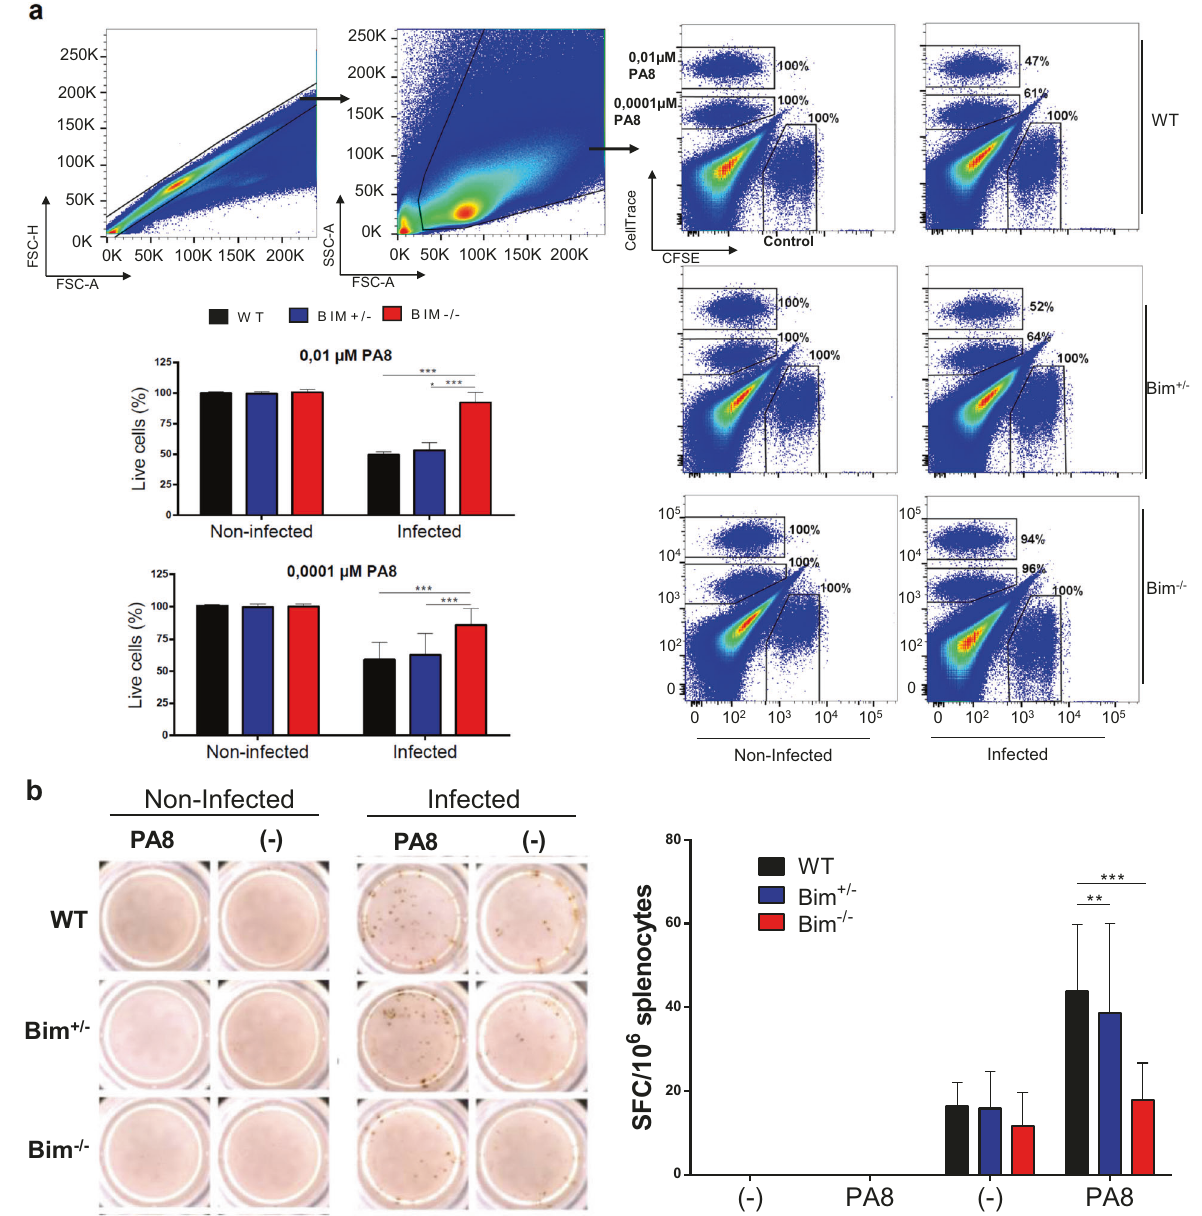
Fig. 4 Bim − / − mice have impaired antigen-speci fi c CD8 + T cells response against T. cruzi in the acute phase of infection. C57BL/6 WT , Bim + / − , and Bim − / − mice were inoculated i.p. with 1 × 10 4 trypomastigotes of the Y strain of T. cruzi . A Eight days after infection, mice were inoculated with 3 × 10 7 splenocytes divided into three populations (1:1:1) stained with 1 μ M of CFSE (control), 1 μ M of CellTrace violet (CTV low - pulsed with 0.0001 μ M of PA8 peptide) and 10 μ M of Cell trace (CTV hi - pulsed with 0.01 μ M of PA8 peptide). Sixteen to twenty hours after cell transfer splenocytes were harvested and speci fi c lysis of target cells was determined by fl ow cytometry. B The frequency of IFN- γ producing cells was measured ex vivo in the presence of PA8 peptide by ELISPOT assay. SFC (Spot forming cells). The results are expressed as the media and standard deviation of fi ve animals for the infected group and three animals for the non-infected group. The results are representative of three independent experiments. Statistical analysis was performed using two-way ANOVA, followed by Bonferroni post-test. ** p < 0.01, *** p < γ and IL-6, compared to control animals. IL-6 is an important involved in the activation of CD4 T lymphocytes, which in turn pro-in fl ammatory cytokine that induces the differentiation of improve the humoral immune response [24]. Interestingly, we CD8 + T cells into cytotoxic T cells [31]. Splenocyte de fi ciency in observed that Bim − / − mice have a reduced percentage of the SPM population when compared to the WT and Bim + / − counterparts at IL-6 and/or IFN- γ could also contribute to the establishment of the high parasitic load observed 9 days after infection and/or to the peak of parasitemia. the de fi cit to fully control parasitemia observed in 25% of mice Besides the potential de fi cient local response at the that succumb from the disease. Different studies have shown peritoneal cavity, Bim − / − splenocytes also showed a reduction that production of IFN- γ is correlated with resistance and in NO production as well as in fl ammatory cytokines such as IFN-